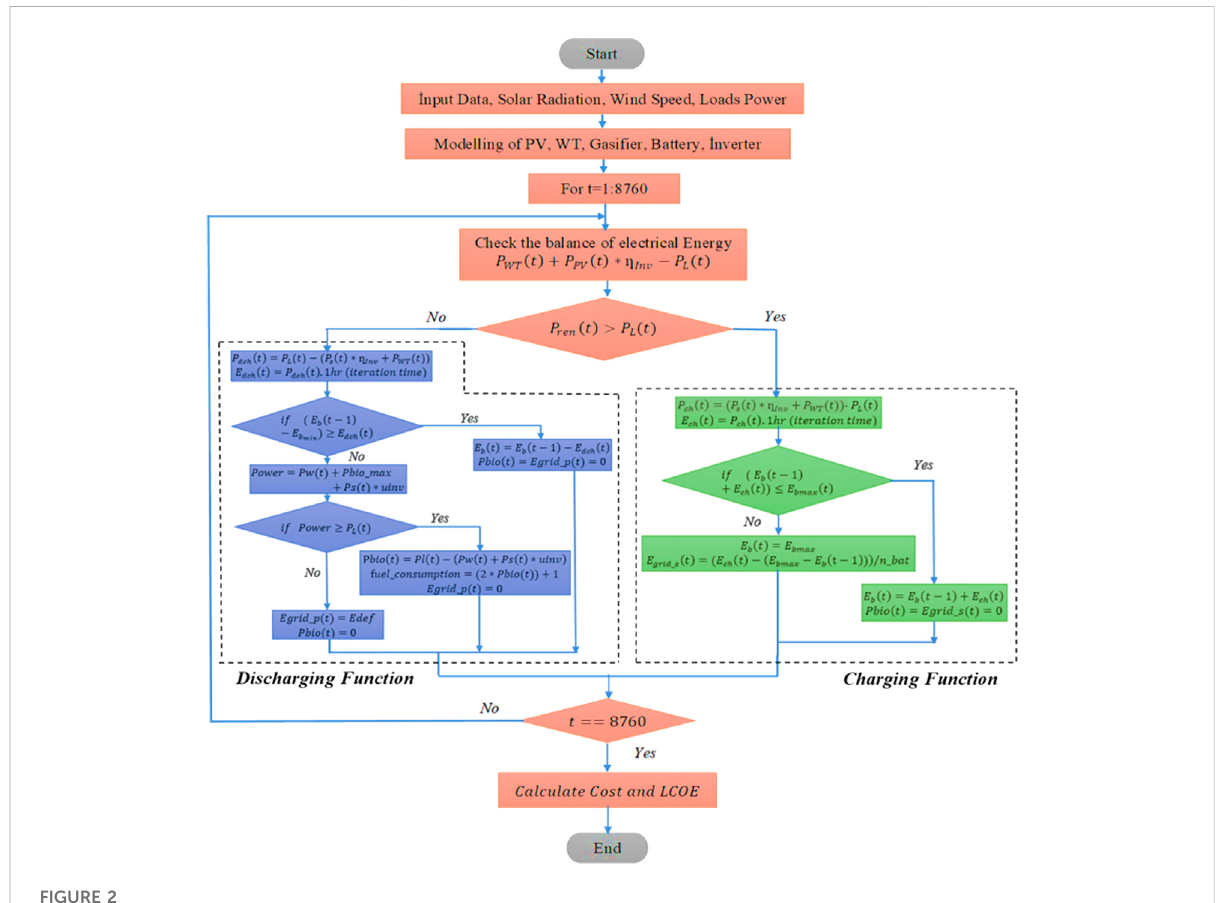
FIGURE 2 The operating strategy fl ow chart of the proposed